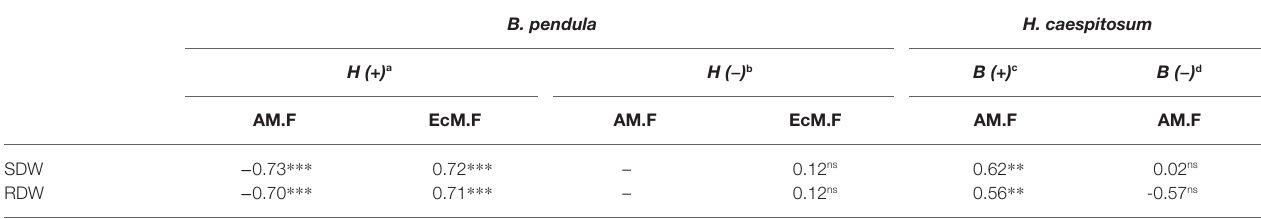
TABLE 1 | Correlations between growth parameters (shoot dry weight, root dry weight) and mycorrhizal colonization (AM.F, EcM.F) in B. pendula and H. caespitosum seedlings, either in presence (+) or absence ( − ) of the opposite mycorrhizal host in the cultivation system. B.